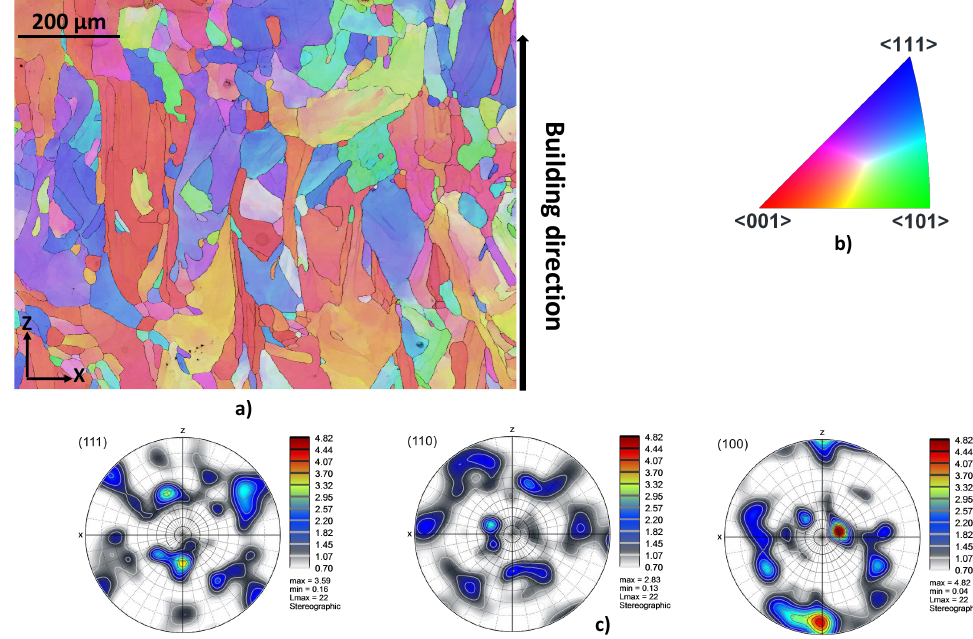
Figure 4. EBSD map taken in the center of the as-LB-PBFed Ti42Nb specimens produced with a building directions of 90 ◦ (projection axes (cid:104) 100 (cid:105) ): ( a ) inverse pole figures (IPF (Z)), ( b ) IPF coloring legend, ( c ) pole figures